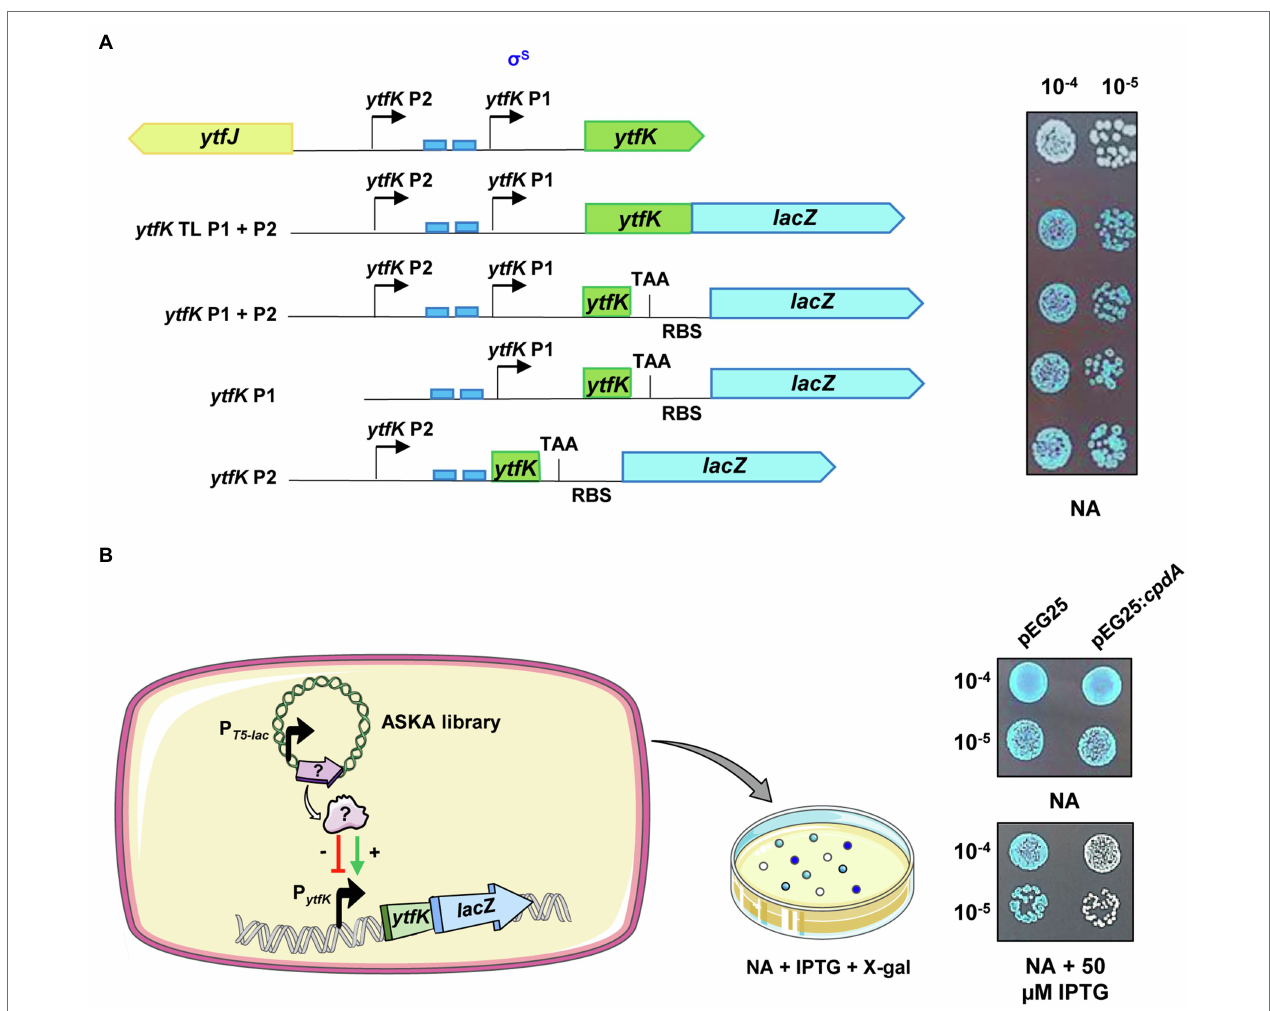
FIGURE 1 | ytfK is transcribed from two distinct promoters. (A) ytfK promoter region. The divergent ytfK and ytfJ genes are represented by green and yellow arrows, respectively. The previously identified (P1) and the putative (P2) transcriptional start sites are indicated by black arrows. The two pho boxes recognized by the response regulator PhoB are visualized by blue rectangles. The following schematic representations describe translational and transcriptional lacZ fusions used in this study and on the right the corresponding expression level as judged by colorimetric visualization of lacZ activity on X-gal plate. Briefly, stationary-phase cultures of TB28 cells harboring translational ( ytfK TL P1 + P2) or transcriptional ( ytfK P1 + P2, ytfK P1, or ytfK P2) fusions were serially diluted and 5 µl of 10 −4 and 10 −5 dilutions were spotted on NA rich solid medium containing X-gal. Results are representative of three independent experiments. (B) Schematic representation of the genetic screen based on overexpression of E. coli genes from a pooled plasmid of ASKA library (Kitagawa et al., 2005) in TB28 cells harboring translational fusion ( ytfK TL P1 + P2) and screening of candidates having dysregulated level of YtfK as judged by colorimetric visualization of lacZ level on X-gal NA plates. On the right, stationary-phase cultures of cells expressing translational fusion ( ytfK TL P1 + P2) and harboring pEG25 or pEG25: cpdA plasmids were serially diluted and spotted on NA rich solid medium supplemented or not with 50 μ M IPTG and X-gal. Results are representative of three independent